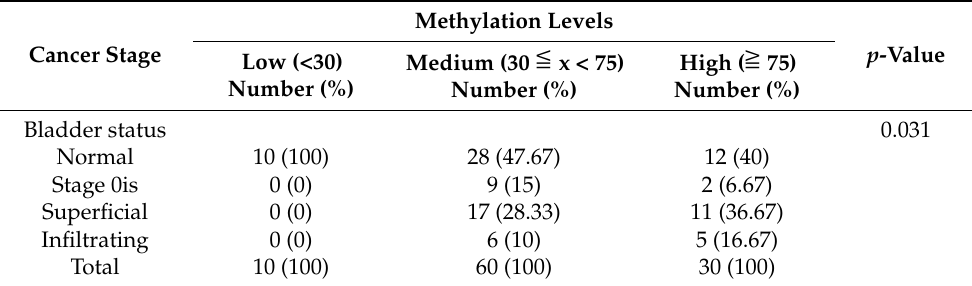
Table 3. GSTM5 gene methylation levels of 50 patients with bladder cancer and 50 healthy indi- viduals. The methylation level is divided into 3 classes (low, medium and high). Table 4. The correlation between GSTM5 gene methylation levels and bladder cancer stages in 100 subjects. The methylation level is divided into 3 classes (low, medium and high).